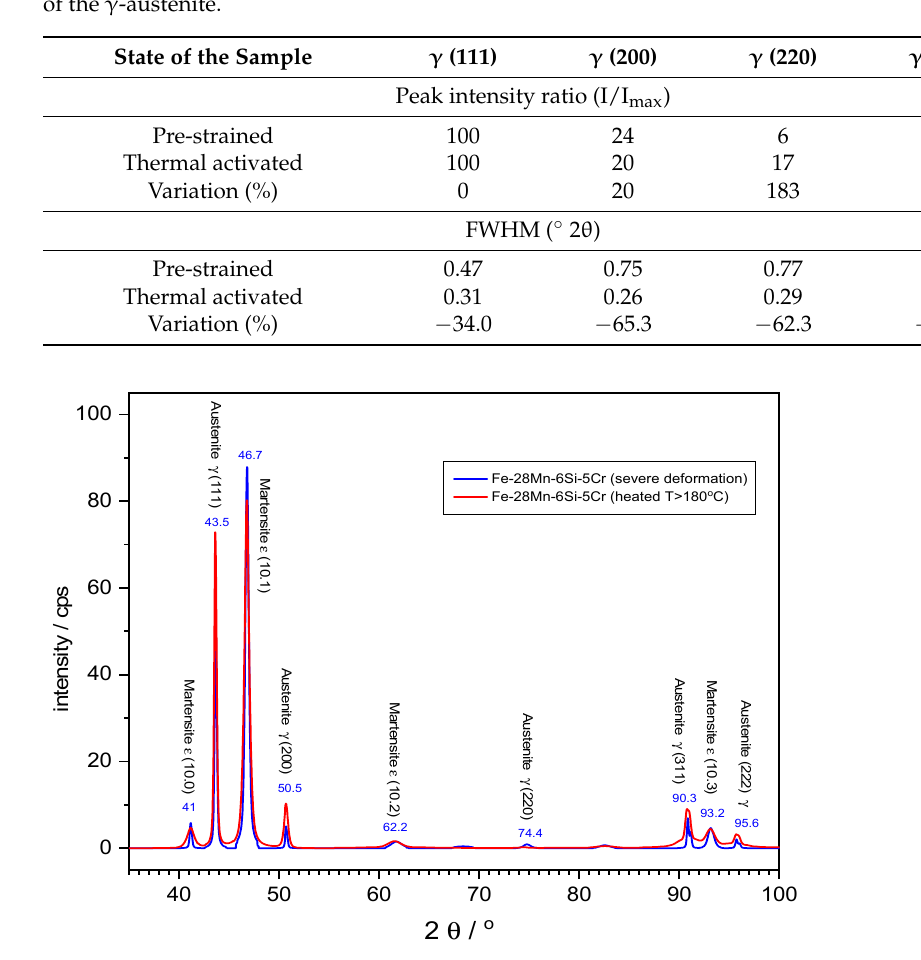
Figure 6. XRD patterns corresponding to the Fe-28Mn-6Si-5Cr alloy after severe straining (blue) and after heating at 180 °C for 5 min.